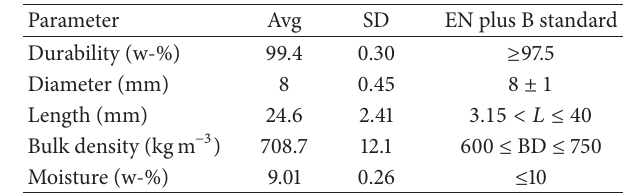
Table 4: Characteristics of cha˜nar husk before pelleting. Table 5: Characterization of cha˜nar husk